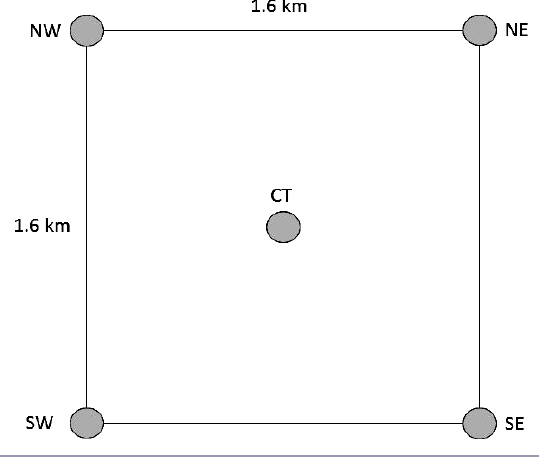
Fig. 2 . Configuration of stations within each site.